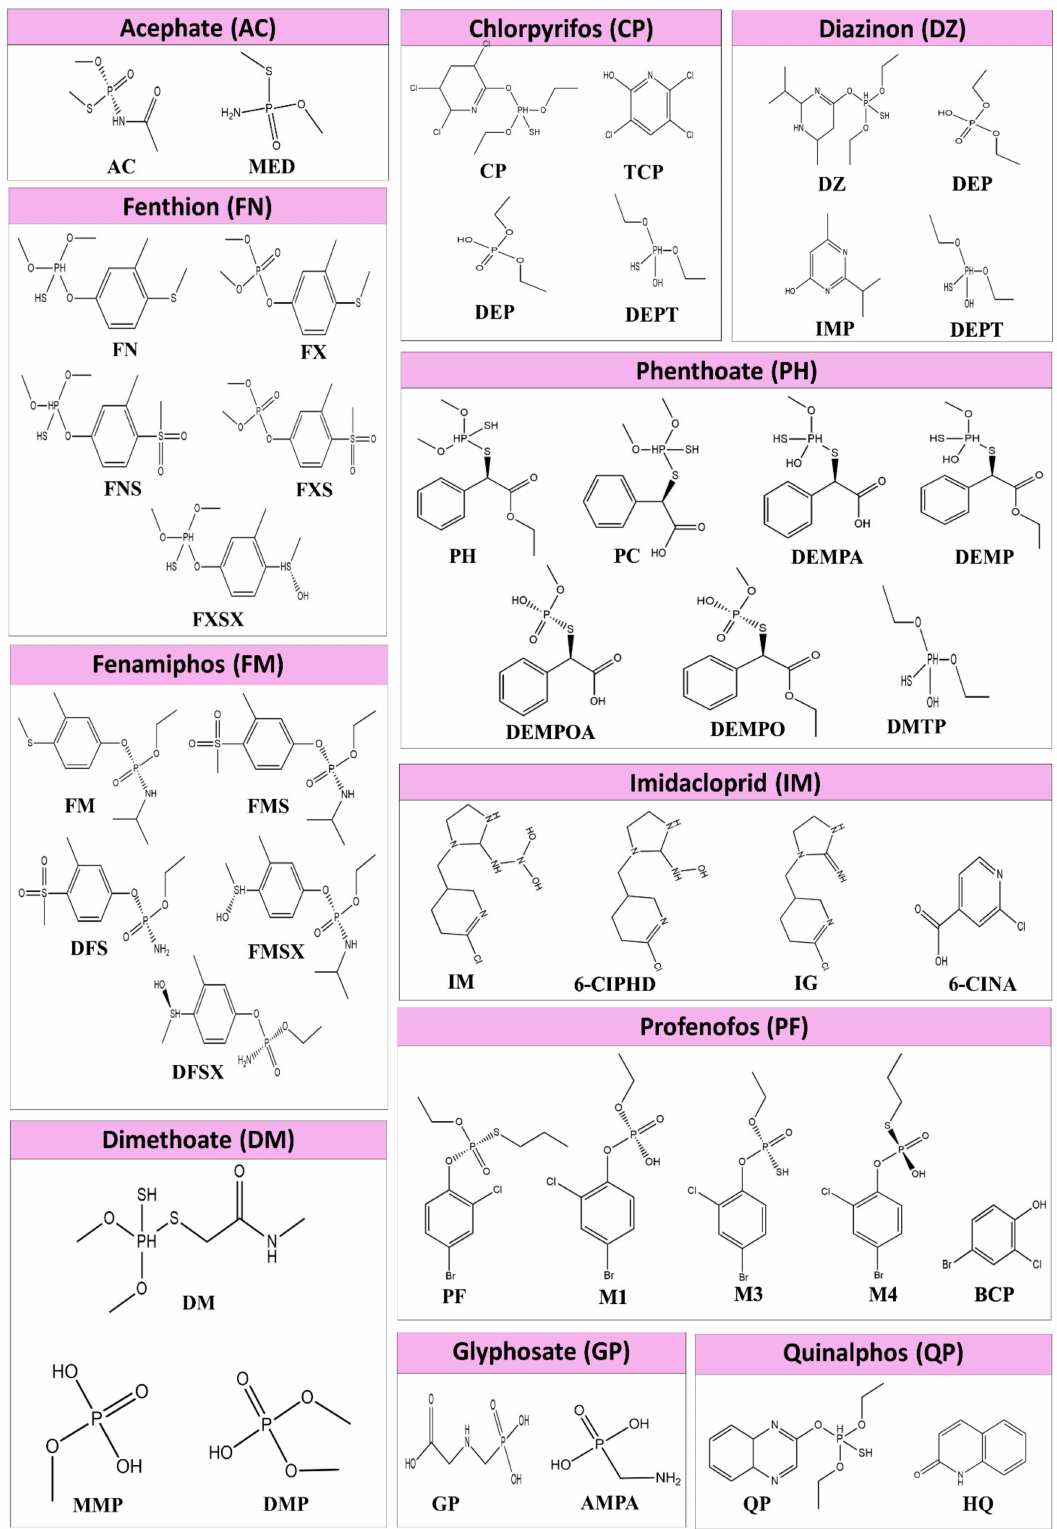
Figure 1. Structures of pesticides and metabolites evaluated in this work. Acephate (AC), chlorpyrifos (CP), diazinon (DZ), dimethoate (DM), fenthion (FN), fenamiphos (FM), phenthoate (PH), profenofos (PF), quinalphos (QP), imidacloprid (IM), and Glyphosate (GP) pesticides and their metabolites, which were experimentally found in urine and and blood samples of poisoned individuals are shown in the figure. The full names for the pesticides and metabolites are mentioned in Table